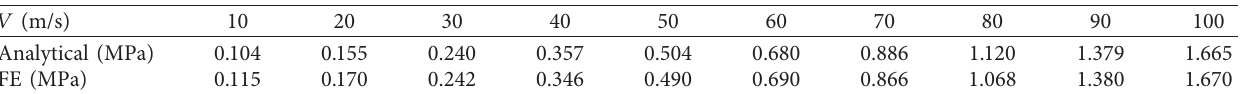
Figure 15: FE prediction of the dynamic collapse response of DHH, N � 5 and ρ � 5%. (a) Impact in the x direction, V � 50m/s. (b) Impact in the z direction, V � 50m/s. (c) Impact in the x direction, V � 200m/s. (d) Impact in the z direction, V � 200m / s. Table 3: The dynamic collapse stress of DHHs under uniaxial compression in the x direction, N � 5 and ρ � 5%.